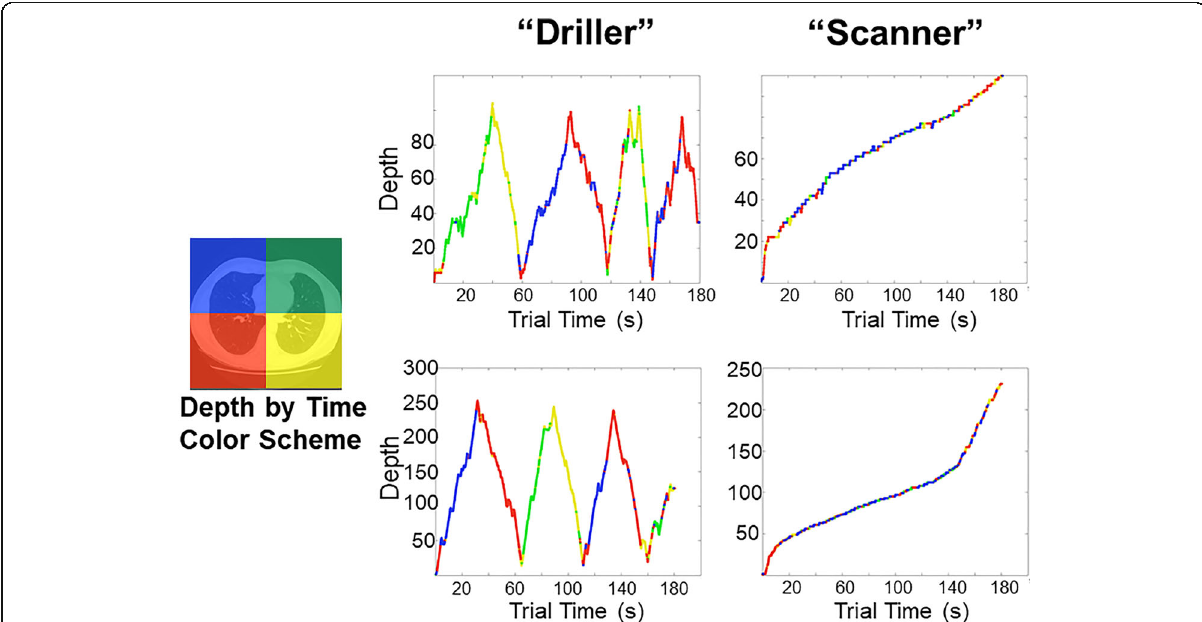
Fig. 4 Two strategies emerge when searching through chest computed tomography (CT) scans for lung nodules: scanning and drilling. Scanners move their eyes along the two-dimensional plane while slowly scrolling through depth. In contrast, Drillers keep their eyes relatively stationary in one region at a time while rapidly scrolling through depth. At present, it is largely unknown how these strategies translate to other modalities or tasks. Figure reprinted with permission from Rubin et al. (2018). Perception of volumetric data. In Handbook of medical image perception & technology (Vol. 2). Cambridge, United Kingdom: Cambridge University Press. Original figure was recreated from Drew, Võ, Olwal, et al. (2013). Scanners and drillers: characterizing expert visual search through volumetric images. Journal of Vision , 13 (10),